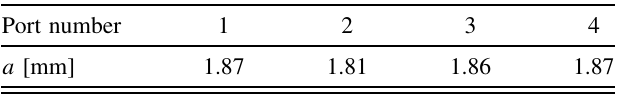
TABLE IV. Measured cone tip diameter of the fabricated non- hermetic prototype.